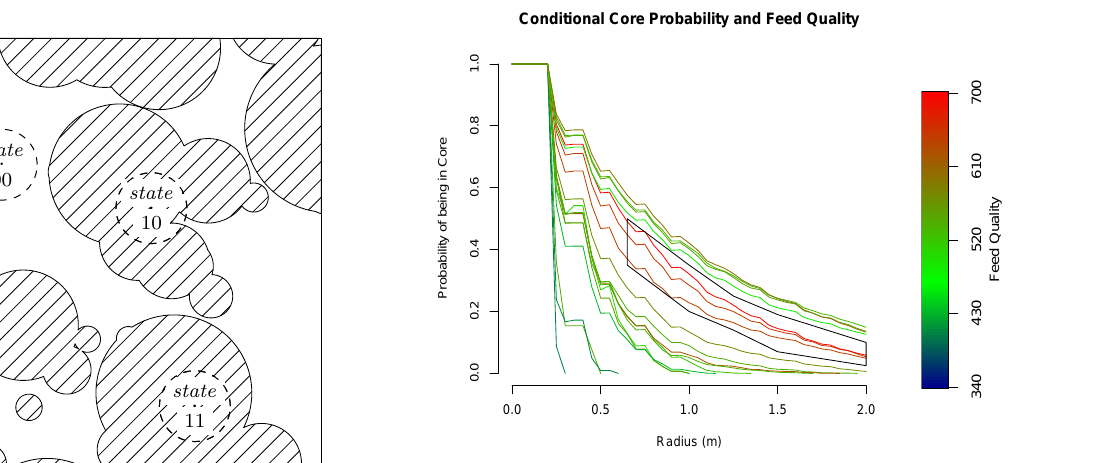
Figure 4: Conditional core probability for tree canopy above 4 m . Each location/observation is a different